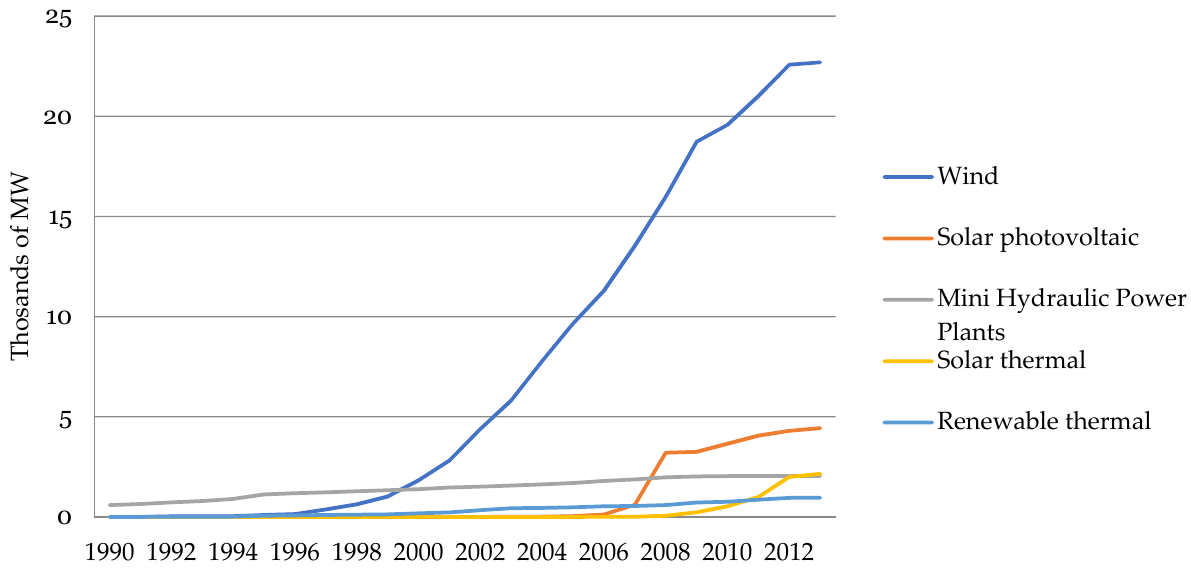
Figure 4. Installed power in renewable energies (1990–2013). Source: REE data.